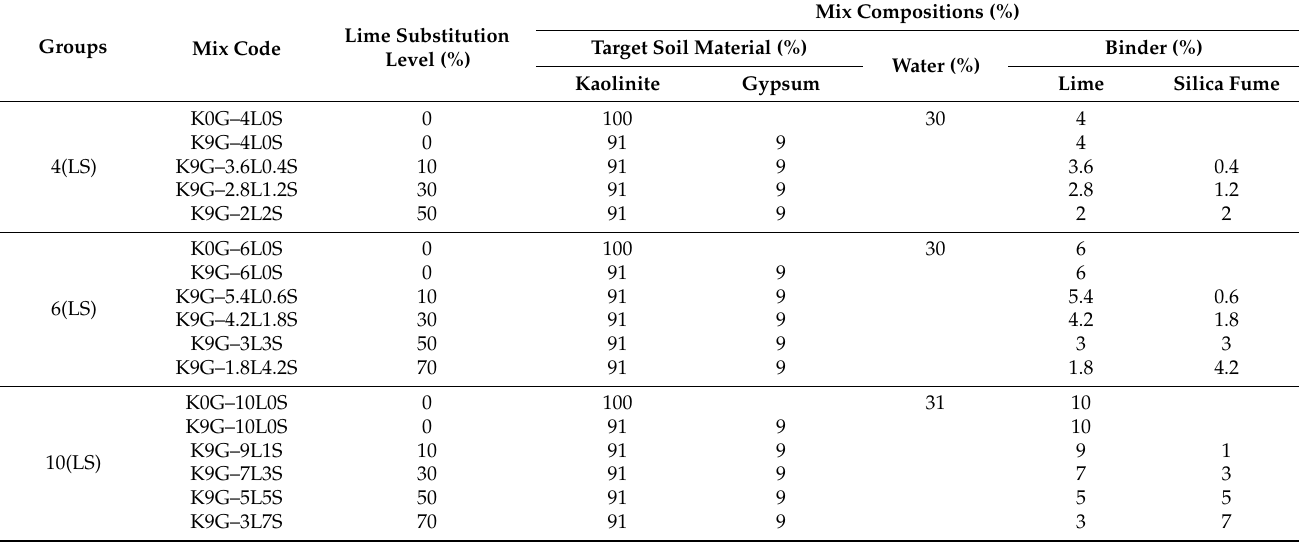
Table 3. Mix composition of artificial kaolinite specimens made with different gypsum concentrations (0 and 9 wt%) and stabilised with binary blends of lima (L) and silica fume